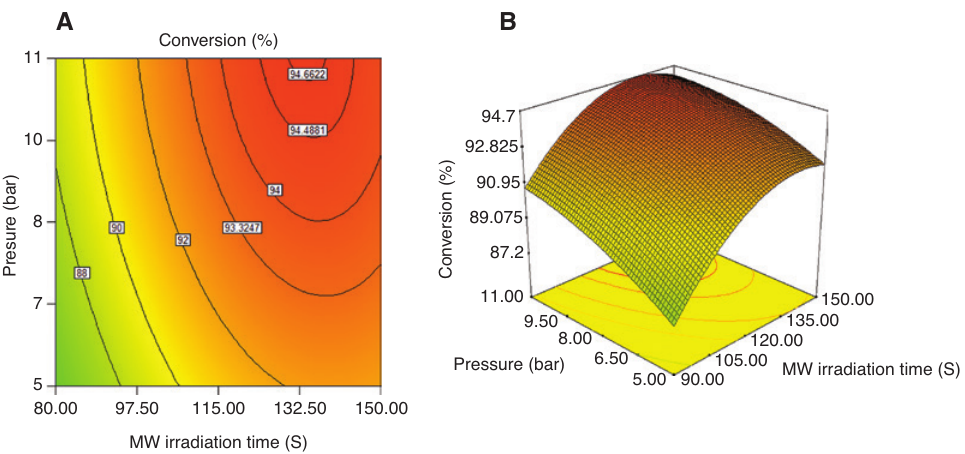
Figure 4: (A) 2D and (B) 3D interaction effect of MW irradiation time and pressure on FAME